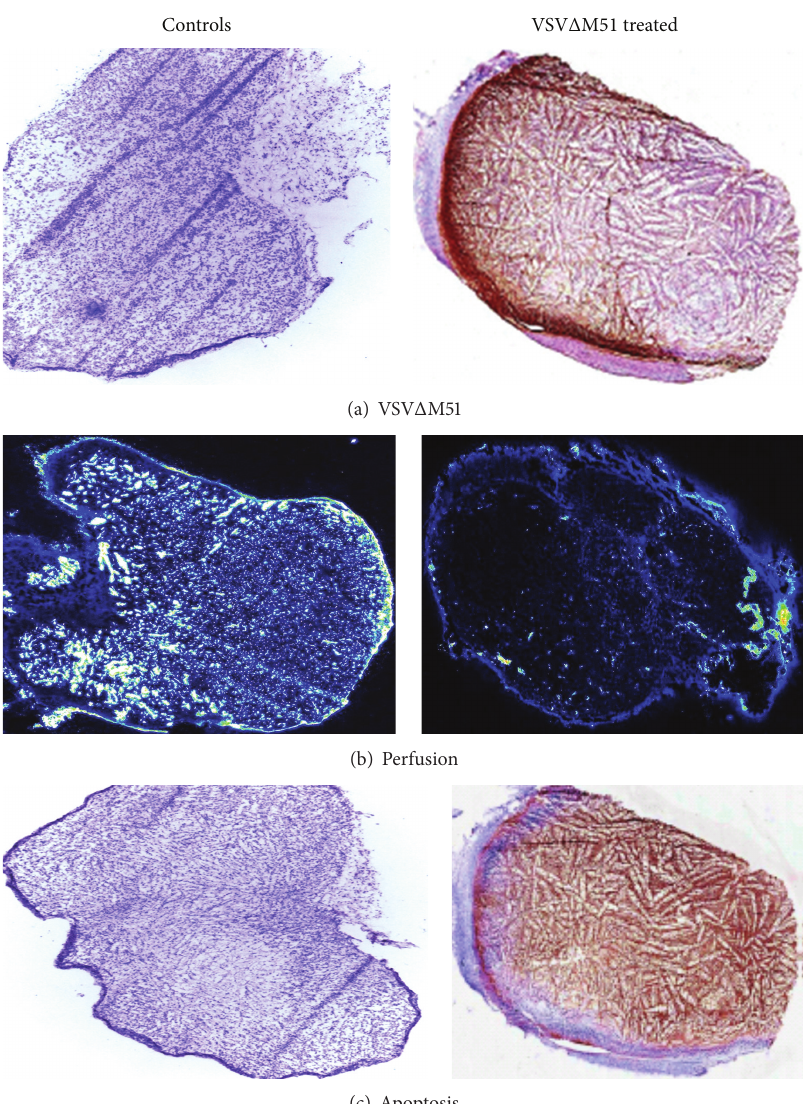
Figure 6: VSV Δ M51 treatment leads to apoptosis of tumor cells and profound loss of tumor vasculature. At day 5 after treatment, subcutaneous tumors were harvested. IHC performed on tumor-frozen sections shows robust VSV Δ M51 spread (a) within the tumor mass with corresponding tumor apoptosis (c). Microperfusion studies also indicated significant microvascular compromise postviral treatment (b). Normal controls are